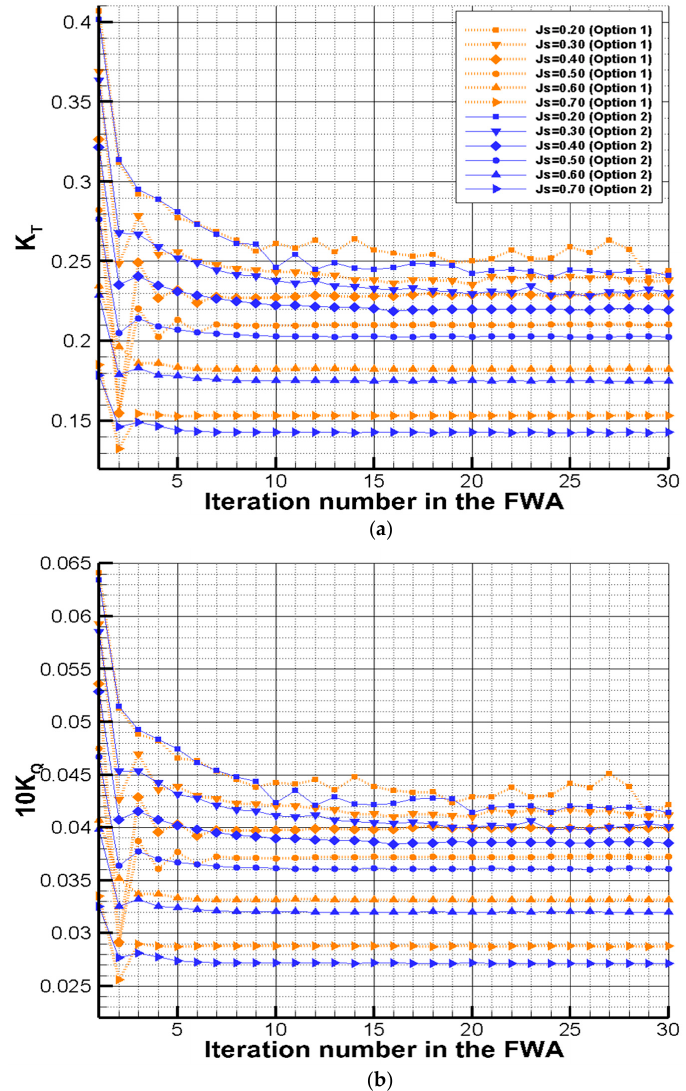
Figure 4. Convergence histories of the predicted K T ( a ) and 10 K Q ( b ) on the blade using FWA with the two repaneling options. A cylindrical wake is assumed.